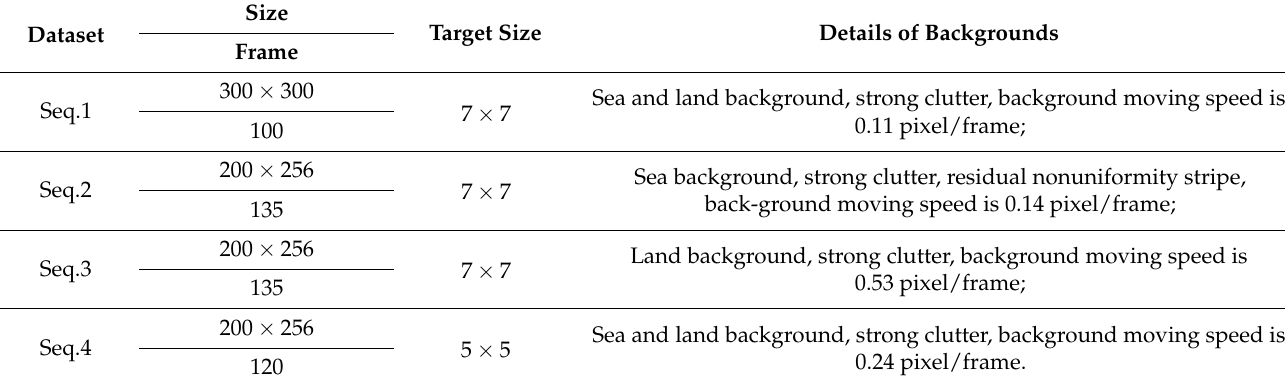
Table 1. Details of experimental